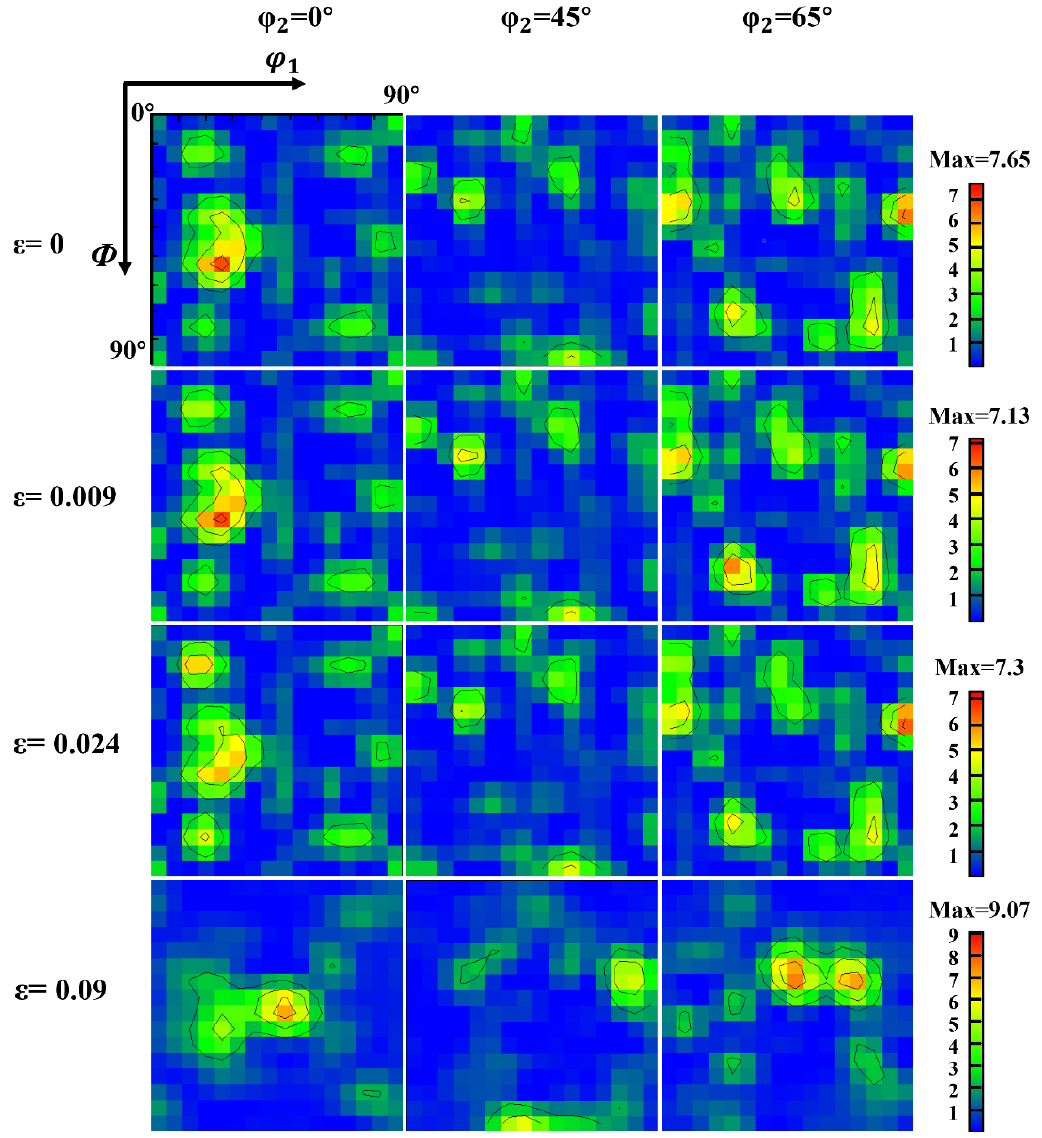
Figure 13. The evolution of the Cr20Ni80 alloy texture for different stress states.